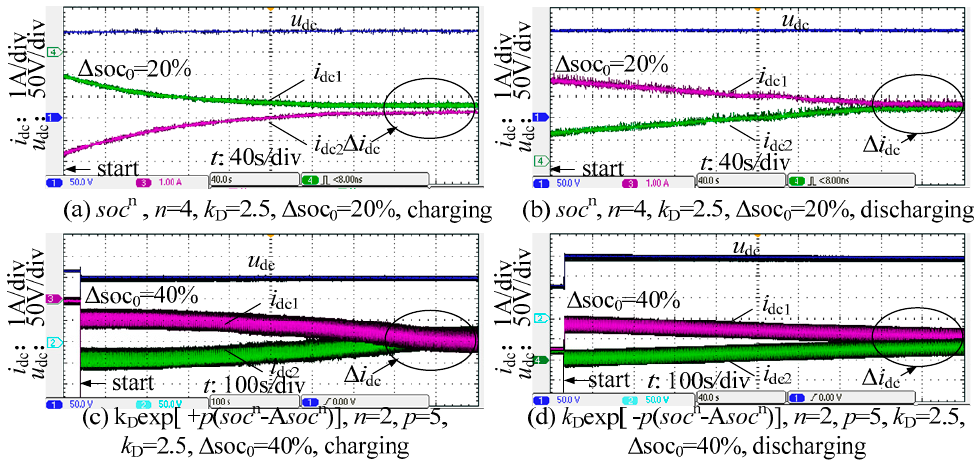
Figure 11. Experimental verification of SOC droop control.